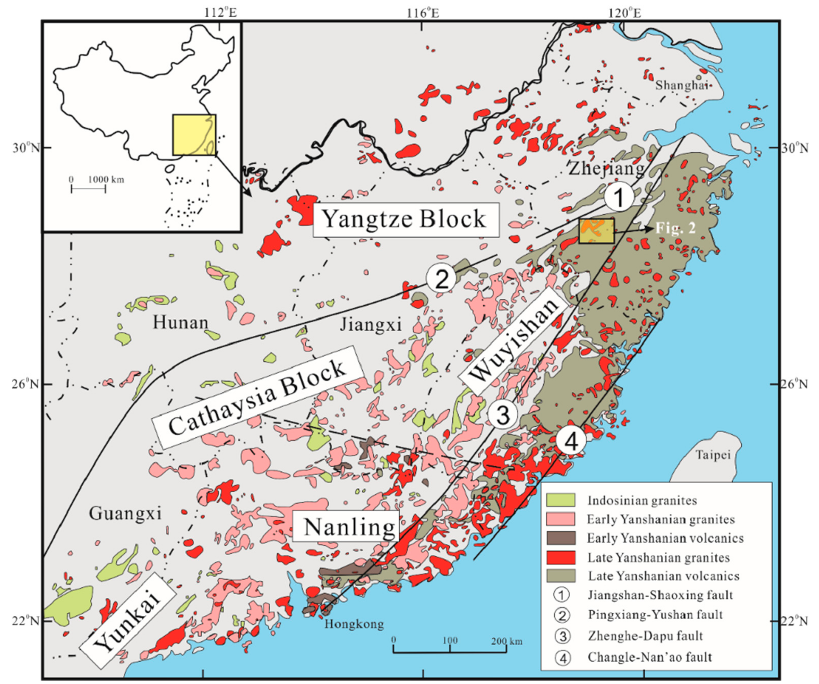
Figure 1. Simplified geological map of South China showing the distribution of Mesozoic granitoid and volcanic rocks (modified after Liu et al. [30]).